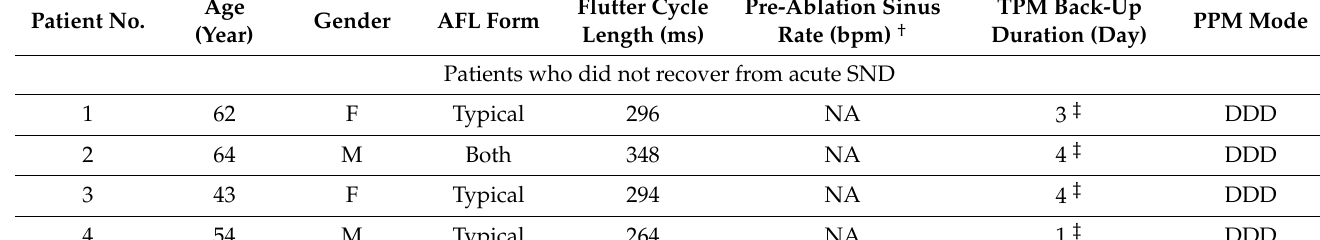
Figure 1. Flow chart of the studied patients. AFL: atrial flutter; PPM: permanent pacemaker; SND: sinus node dysfunction. Table 1. The detailed characteristics of the patients developing acute SND after the AFL ablation.